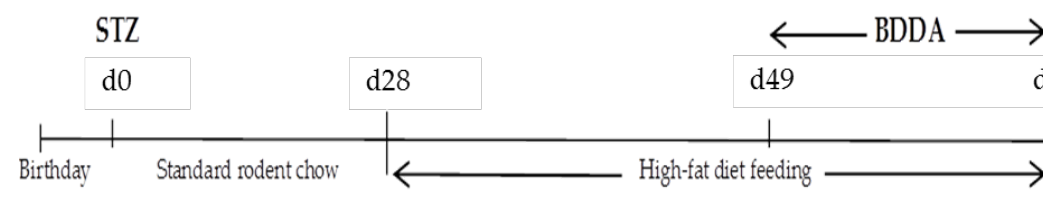
Figure 7. Graphical scheme of the metabolic disorders’ protocols.